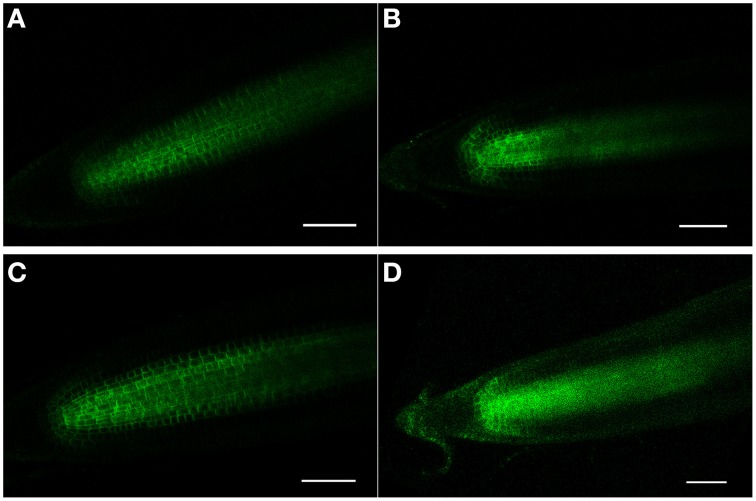
(A–D) PIN1 (PIN1-GFP) confocal localization in Arabidopsis roots, ± salt. (A,C) Control roots (no salt treatment) after 12 and 24 h, respectively. (B,D) Roots treated for 12 and 24 h, respectively, with 150 mM salt. Note that after 24 h of salt treatment that PIN1-GFP expression has become diffuse and is no longer specifically associated with the membranes. Scale bar = 50 μm, n = 6 roots for the control and seven roots for each treatment.